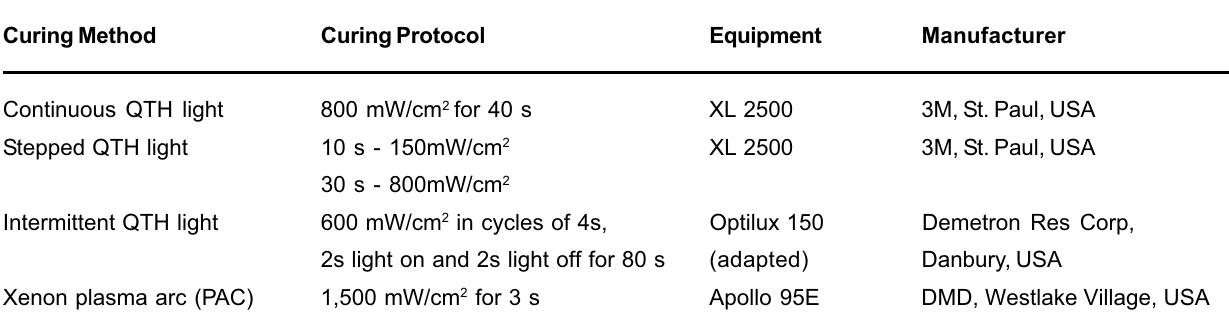
TABLE 2- Stress means in MPa (SD) generated by the photoactivation methods in the both time points